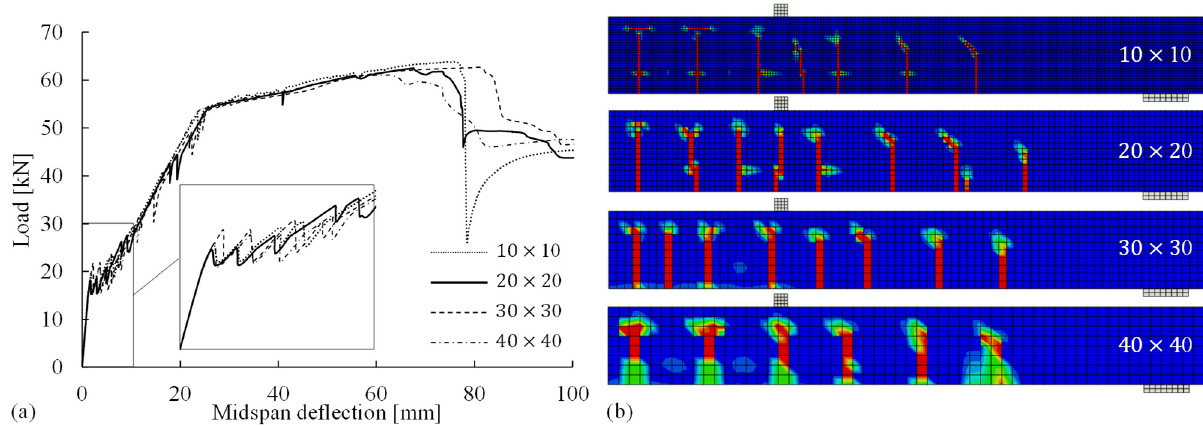
Figure 14. ( a ) Load–midspan deflection relations and ( b ) crack patterns for concrete element sizes of 10, 20, 30, and 40 mm.